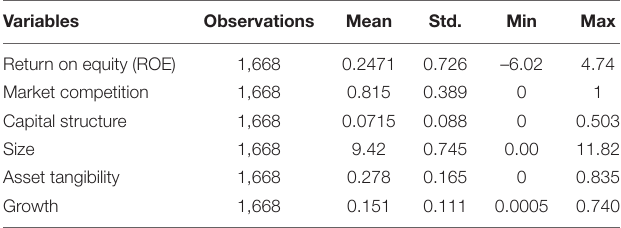
TABLE 1 | It exhibits mean scores, Std. value, minimum and maximum